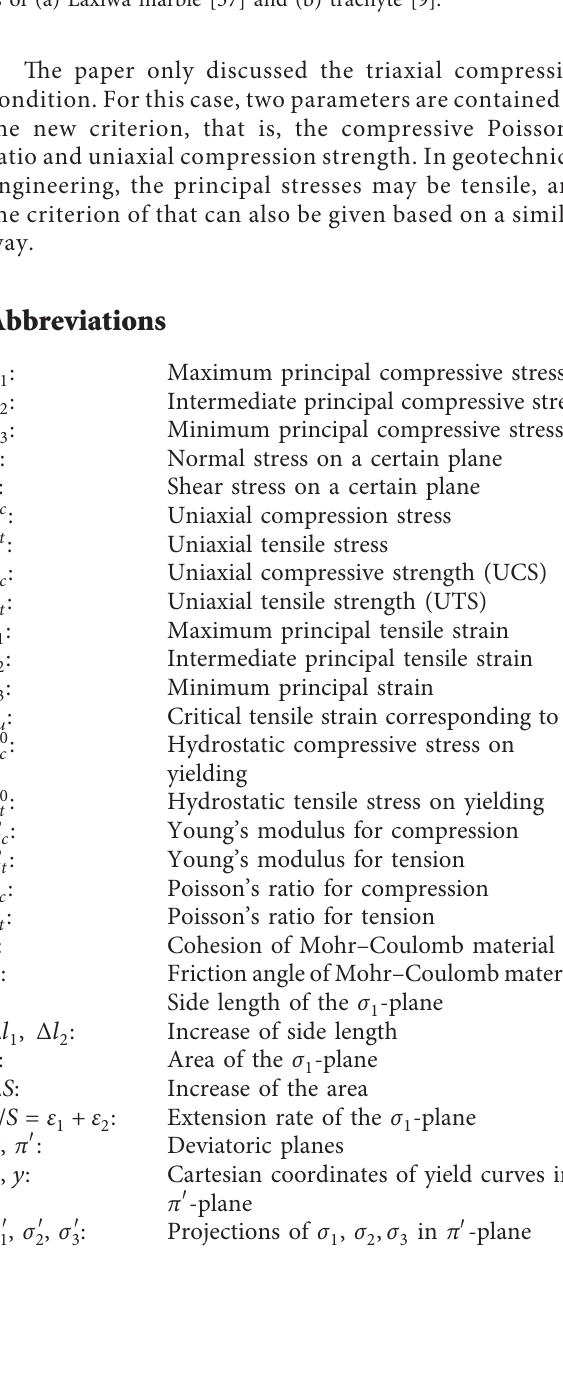
Figure 11: True triaxial test data and theoretical results of (a) Laxiwa marble [37] and (b) trachyte